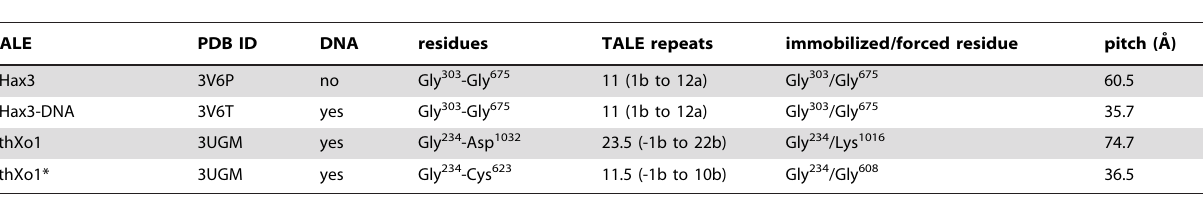
Table 1. Investigated Tal effector